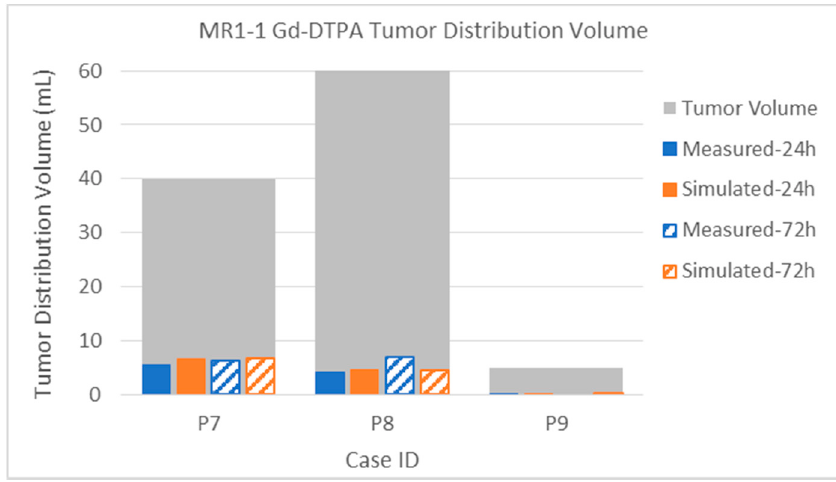
Figure 16. Comparison of measured and simulated Gd-DTPA distribution within contrast-enhancing tumor in MR1-1 patients. Gray bars show tumor volume.